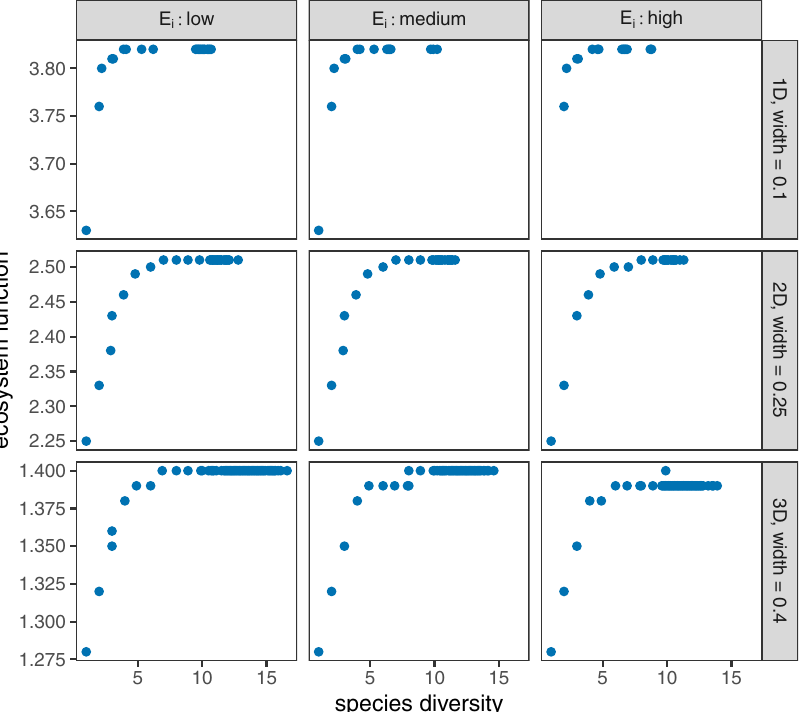
Fig. 4 Ecosystem functioning against species diversity, for various values of trait space dimensionality and competition width (rows) and levels of environmental trait variation (columns). Data (points; n = 480 independent samples per panel) were calculated from the same simulation results that were used in Fig. 3. Ecosystem functioning is measured either by total resource use or biomass production (Supplementary Note 6.3). It always increases with increasing species diversity — despite the fact that functional diversity itself declines with species diversity, as shown by Fig.